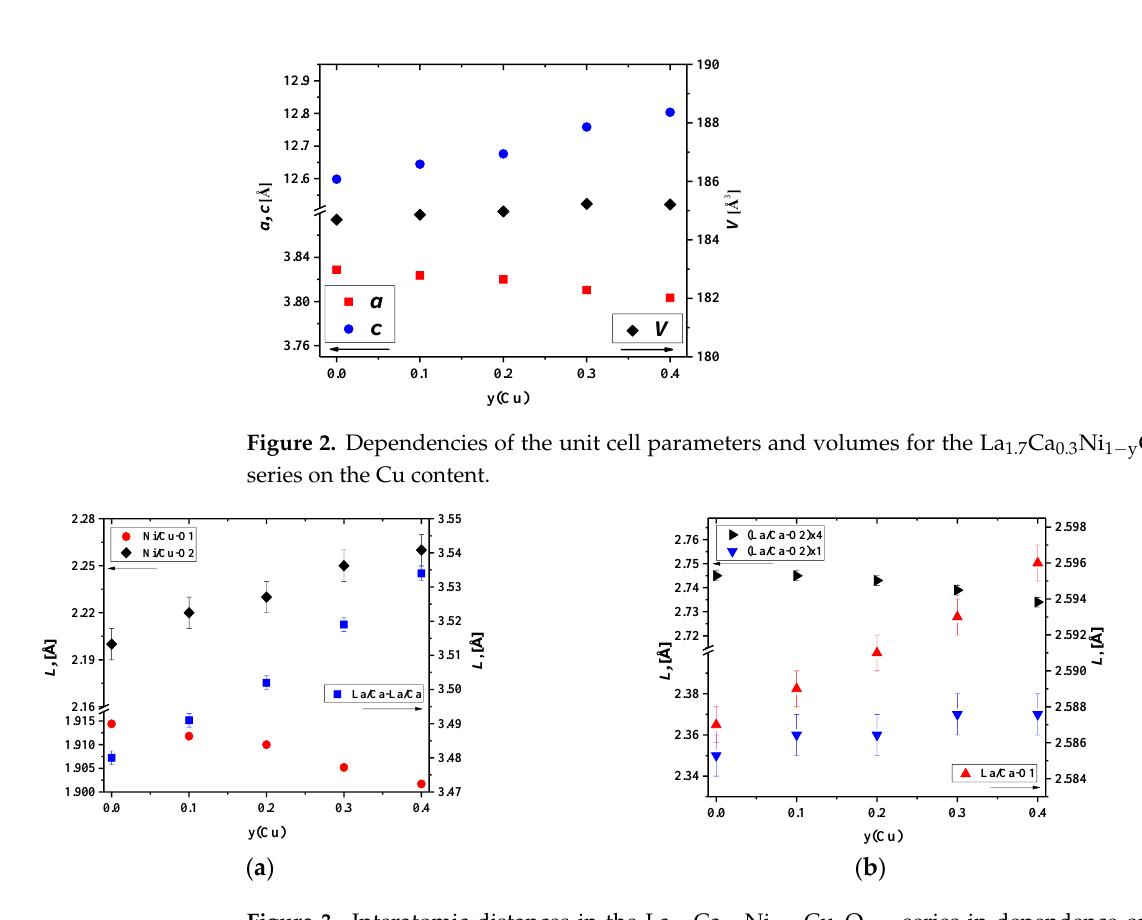
Figure 3. Interatomic distances in the La 1.7 Cа 0.3 Ni 1−y Cu y O 4+δ series in dependence on the Cu content: ( a ) Ni/Cu – O, and ( b ) La/Ca – La/Ca, La/Ca –